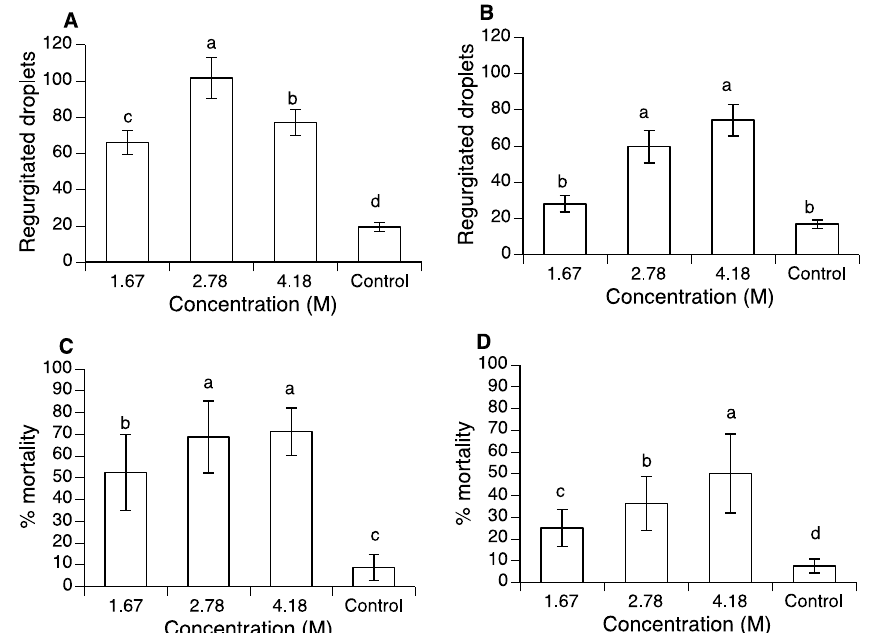
Figure 1. ( A ) and ( B ) Mean (± standard error (SE)) number of regurgitated droplets deposited on cup walls by A . ludens flies exposed to three different concentrations of ( A ) propylene glycol (PG) and ( B ) glycerol in mixtures with sucrose. ( C ) and ( D ) Percentage of mortality observed at 72 h post-treatment for ( C ) PG and ( D ) glycerol treatments, respectively. Columns headed by the same letter are not significantly different (generalized linear model (GLM) post-hoc contrasts, at the p = 0.05